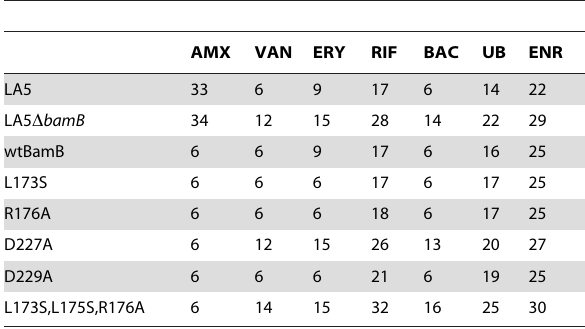
Table 1. Impact of bamB point mutations on antibiotic susceptibility of S. Enteritidis.